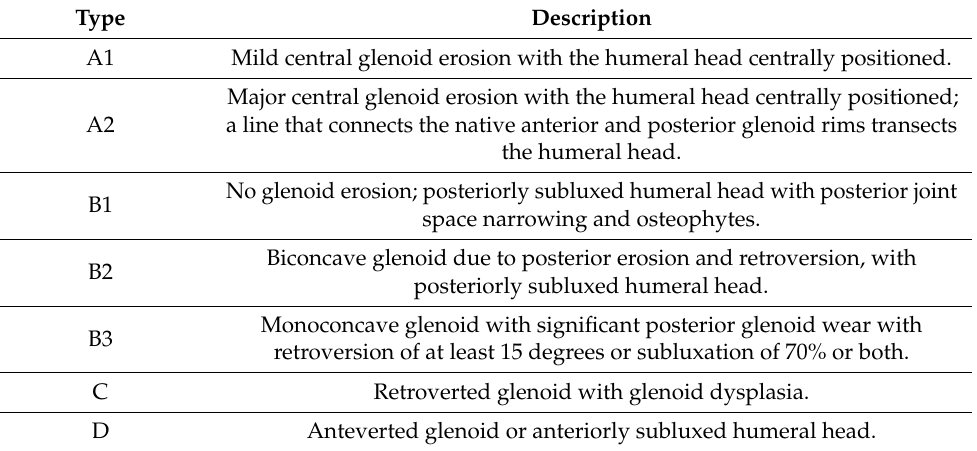
Table 1. Modified Walch Classification. Glenoid shape is classified by erosion location as well as humeral head